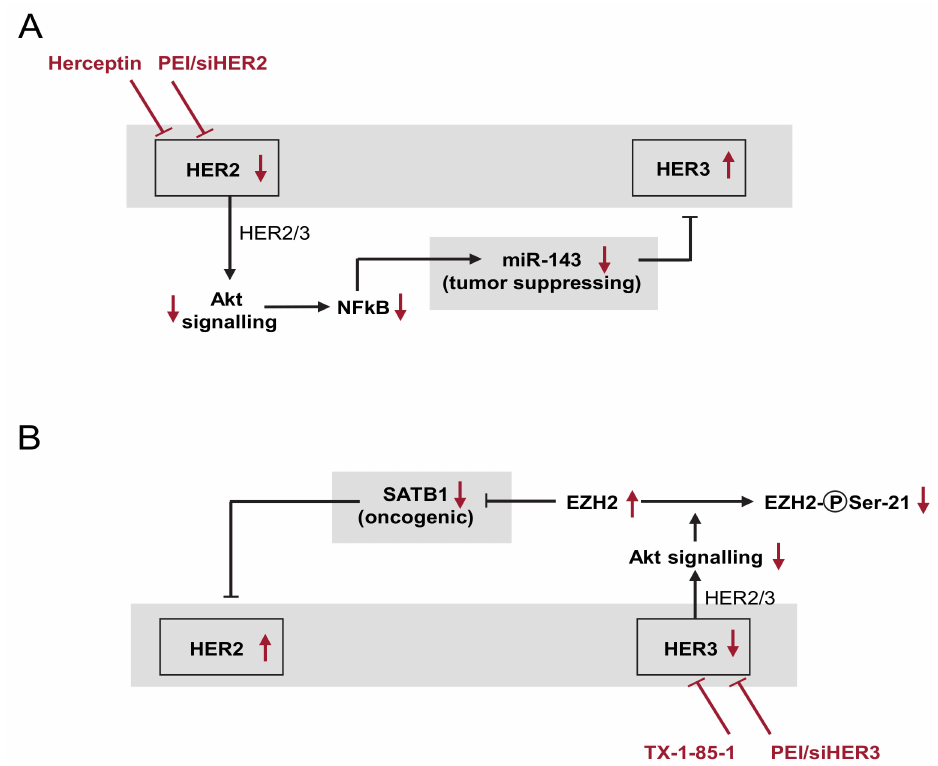
Figure 6. Schematic overview of the network of HER counter-(up)regulation processes (details: see text). ( A ) Effects upon the PEI/siHER2-mediated knockdown or the trastuzumab (Herceptin)-mediated inhibition of HER2, leading to HER3 upregulation. ( B ) HER3 knockdown or TX1-85-1-mediated inhibition with subsequent HER2 upregulation. Red arrows indicate the effects upon the respective inhibition or